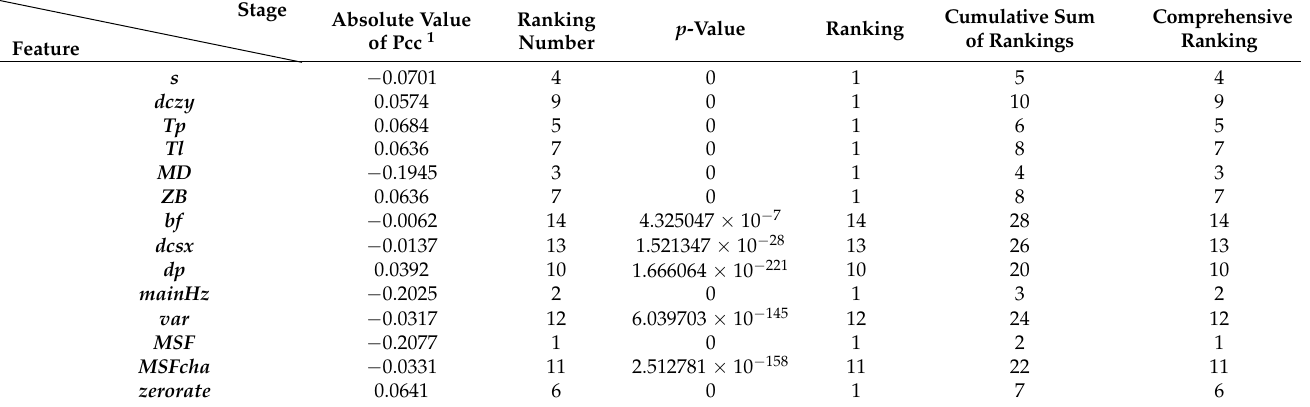
Table 7. Feature selection effects of the material